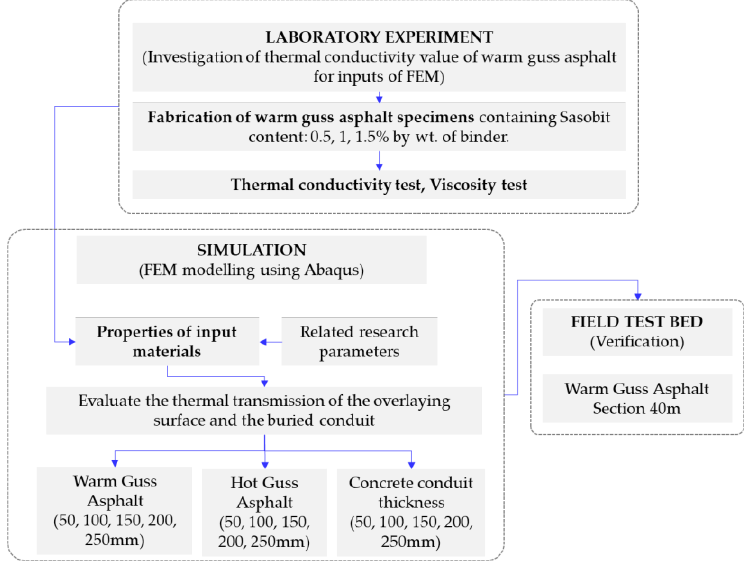
Figure 1. Research flowchart.